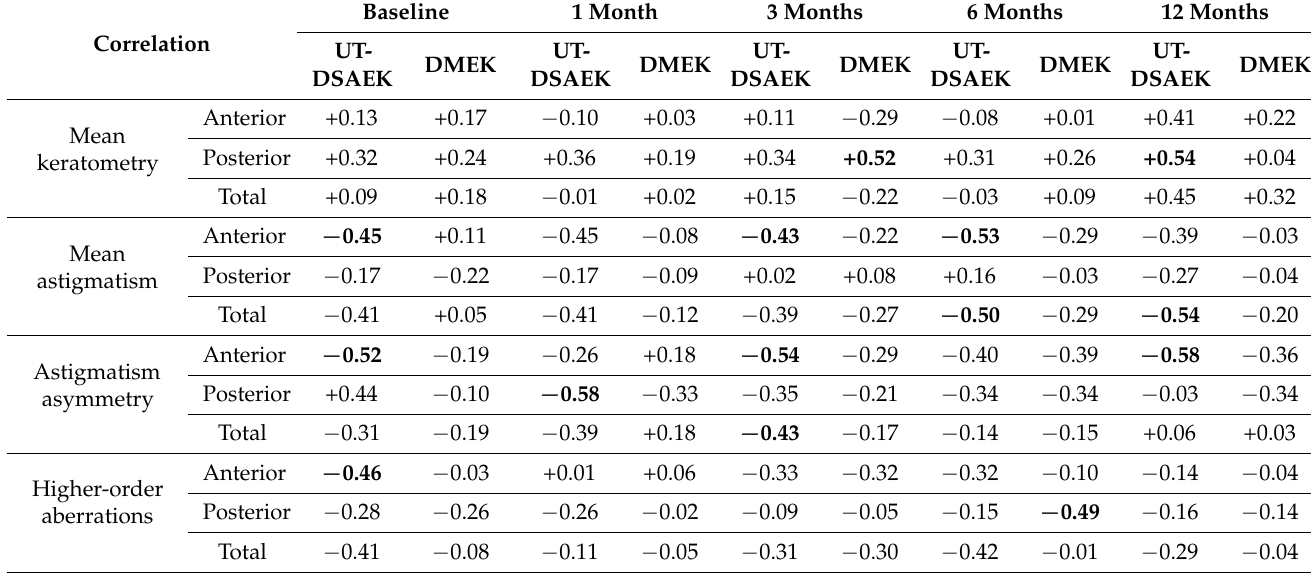
Table 4. The correlations between the best-corrected visual acuity (BCVA) and the magnitudes of the keratometry, astig- matism, astigmatism asymmetry and higher-order aberrations that were obtained in the 3 mm optical zones in the eyes after Descemet membrane endothelial keratoplasty (DMEK) and ultrathin Descemet stripping automated endothelial keratoplasty (UT-DSAEK) procedures. Correlations were calculated for the baseline state and then for 4 consecutive time points, i.e., 1, 3, 6 and 12 months, after the surgery. Statistically significant values are shown in bold.